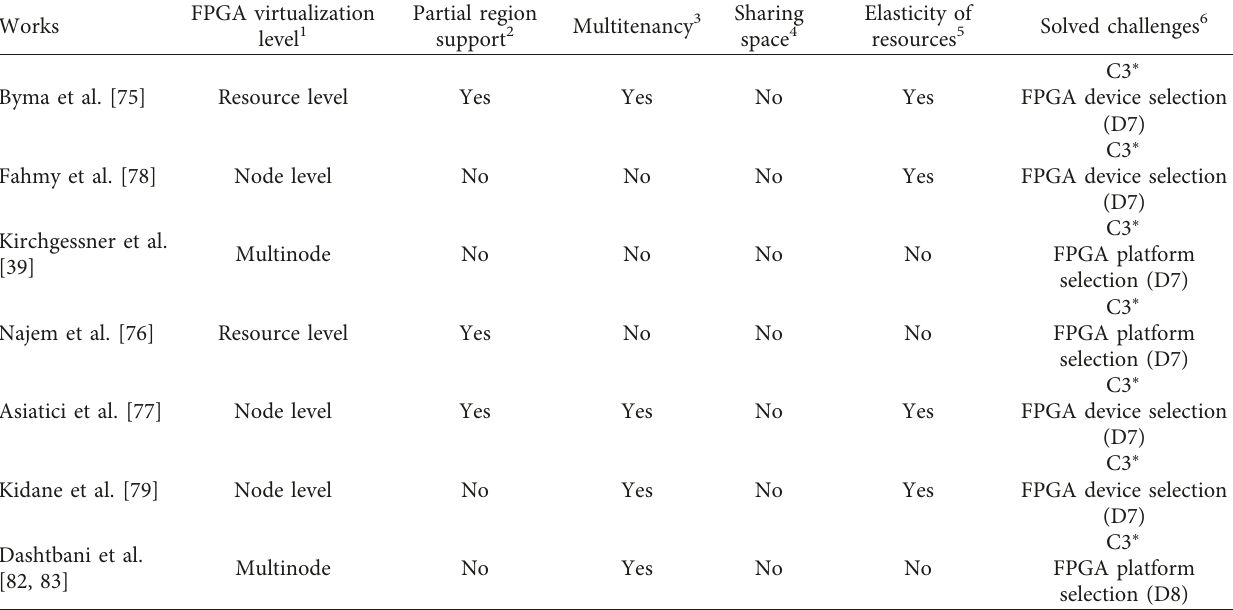
Table 5: Summary of FPGA resources as a